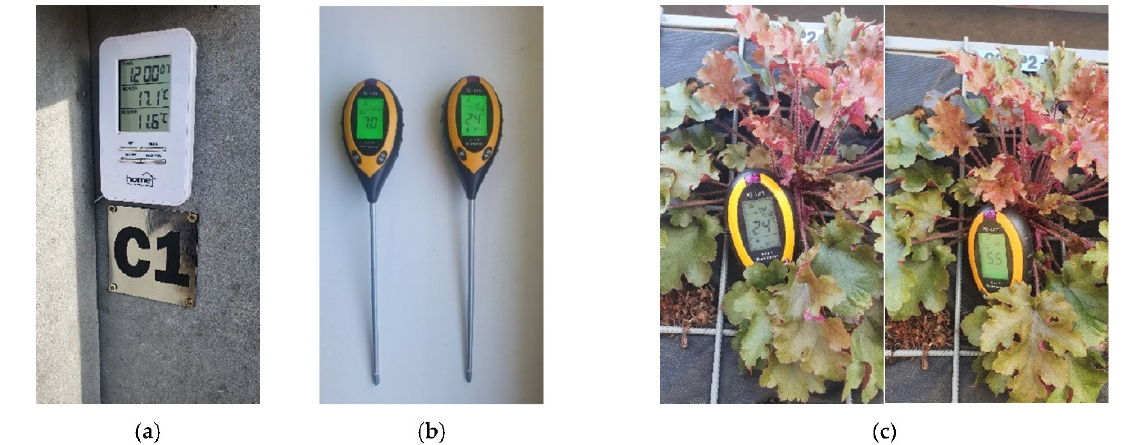
Figure 4. Devices used to monitor the parameters of the soil (pH, humidity, and temperature) and of the outside environment (light intensity and temperature). ( a ) Fixed devices used to measure indoor and outdoor temperature; ( b ) mobile device for measuring luminous intensity, pH, temperature, and humidity; and ( c ) method of measuring the monitored parameters using the mobile device.